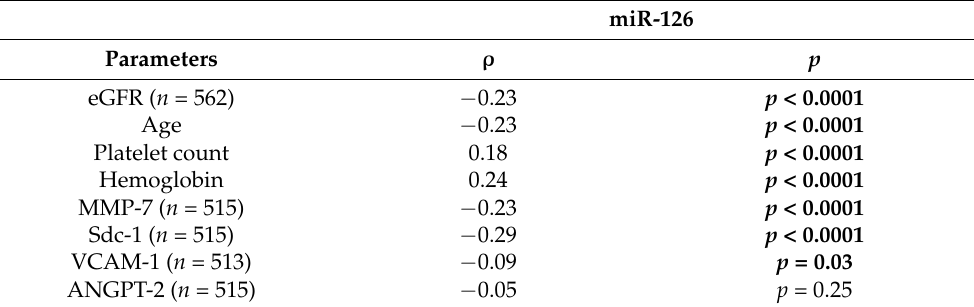
Table 1. Association of miR-126 with endothelial markers using univariate analysis. miR-126 Parameters ρ p eGFR ( n = 562) − 0.23 p < 0.0001 Age − 0.23 p < 0.0001 Platelet count 0.18 p < 0.0001 Hemoglobin 0.24 p < 0.0001 MMP-7 ( n = 515)